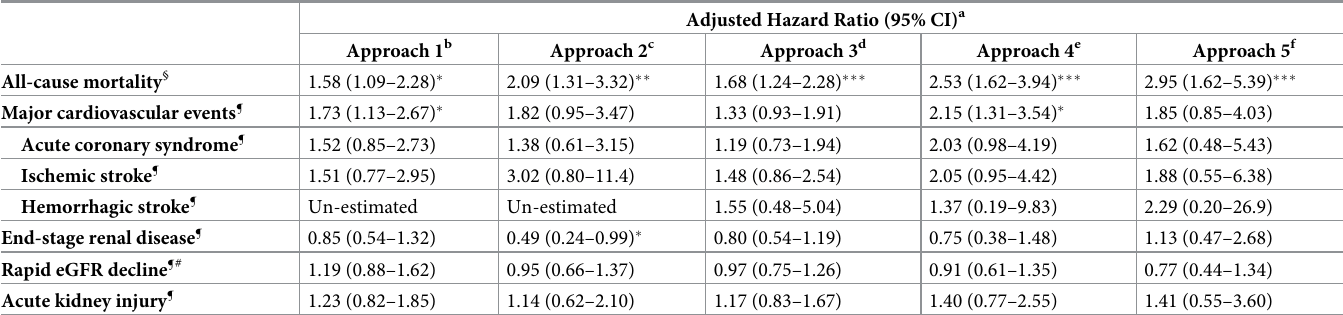
Table 4. Sensitivity analyses showing the outcomes among patients with chronic kidney disease receiving digoxin or